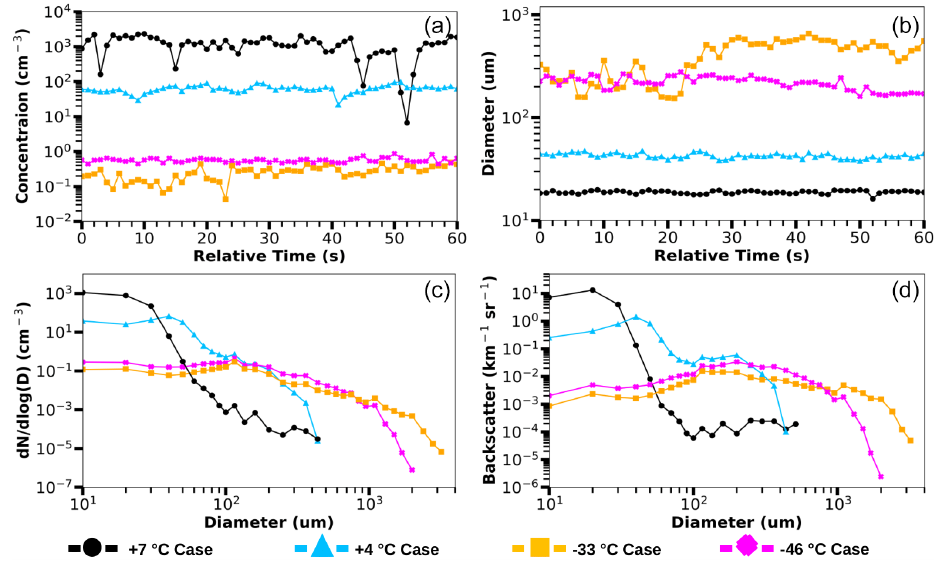
Figure 7. Plots showing measurements within the 60s segments of four analyzed cases (Table 2). The upper left plot (a) is total number concentration measured by the external cloud probes (ECP), specifically the two-dimensional stereo (2D-S) and High-Volume Precipitation Spectrometer Version Three (HVPS3) probes (Table 1). The upper right plot (b) is mean particle diameter measured by the ECP. The lower left plot (c) is a log–log plot of number density function vs. diameter measured by the ECP. The lower right plot (d) shows ECP backscatter coefficient versus the particle diameter. The y axis of plot (d) is not normalized by size channel width; however, neighboring channels typically have simple widths (see Table 1 for details). The ECP backscatter coefficient is obtained from particle data processed with the area-equivalent